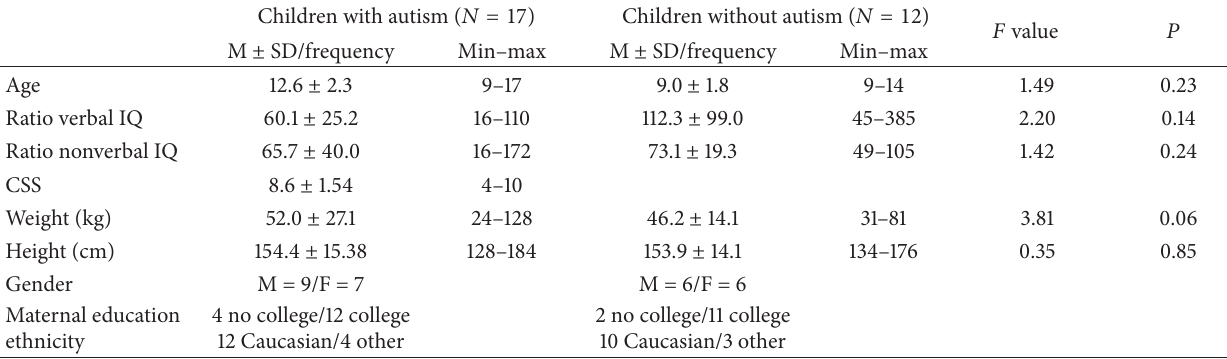
Table 1: Participant demographic information.